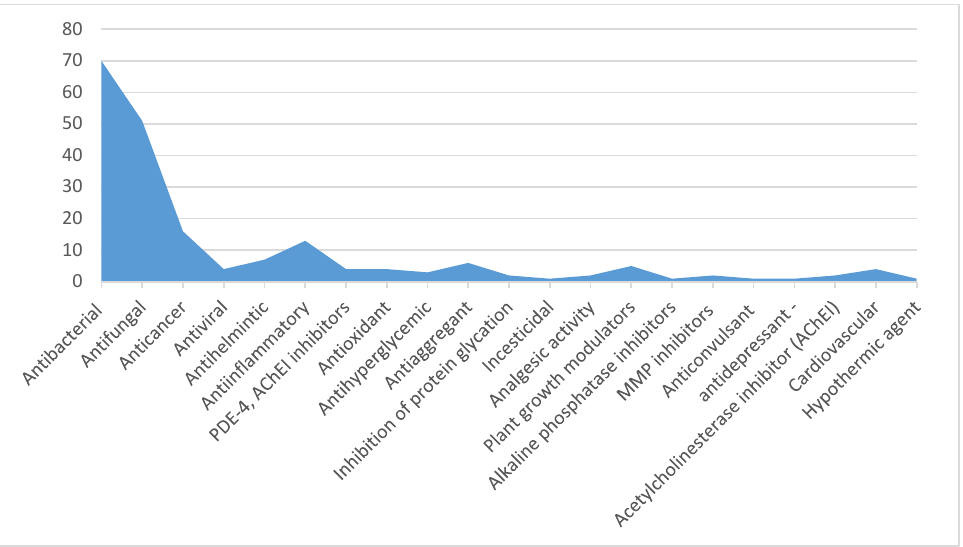
Table 1. Chemical structures of substituted 1,3,4-thiadiazines, mentioned in the text.